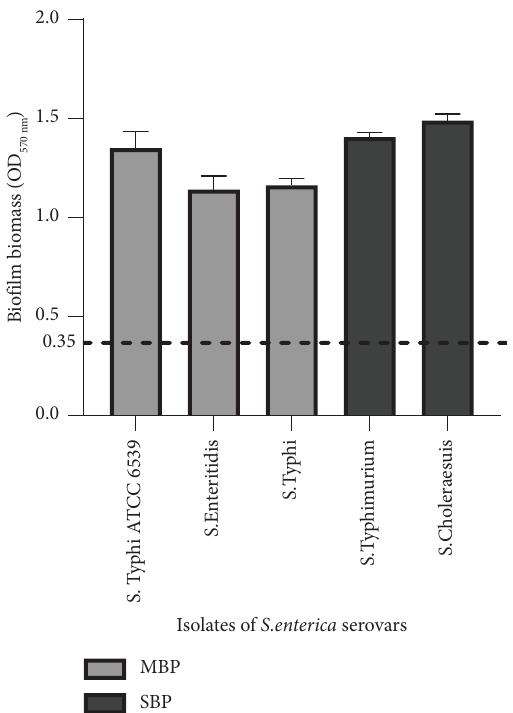
Figure 1: Quantifcation at 570nm of bioflm biomass of Sal- monella enterica serovars by staining with safranin 1%. MBP: moderate bioflm producer; SBP: strong bioflm producer. Te dashed line represents the value of the optical density of control (OD C ) at